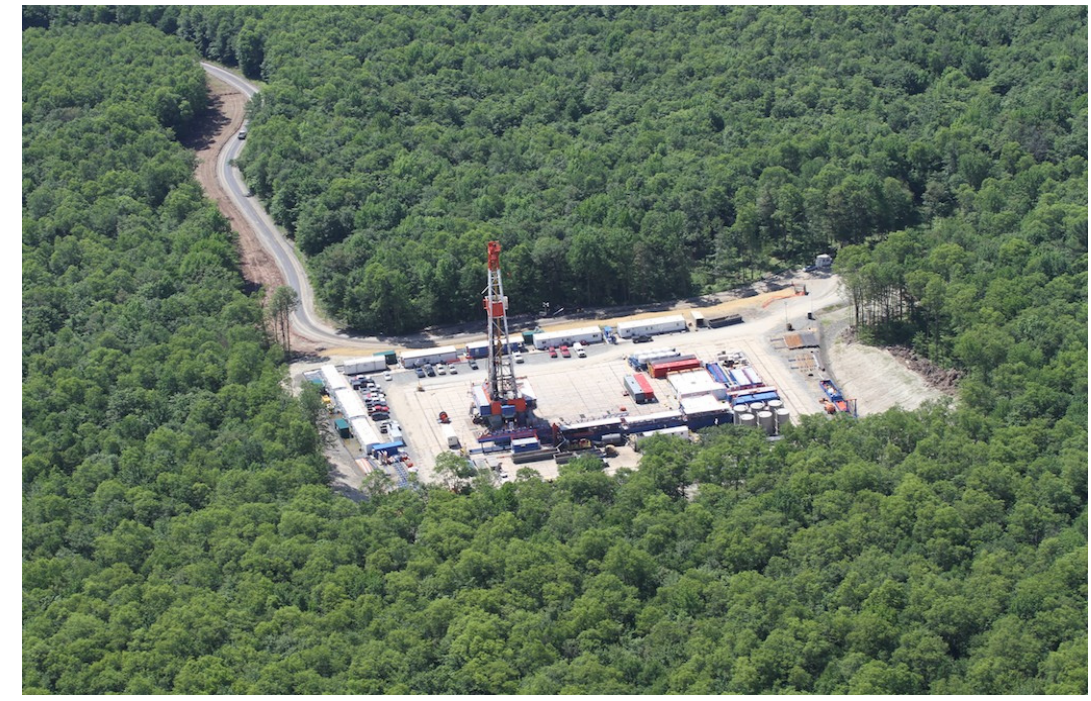
Figure 1. Aerial view of a typical hydraulic fracturing well site in the Marcellus shale basin, U.S. (Photo credit: Bill Howard—The Downstream Project, via